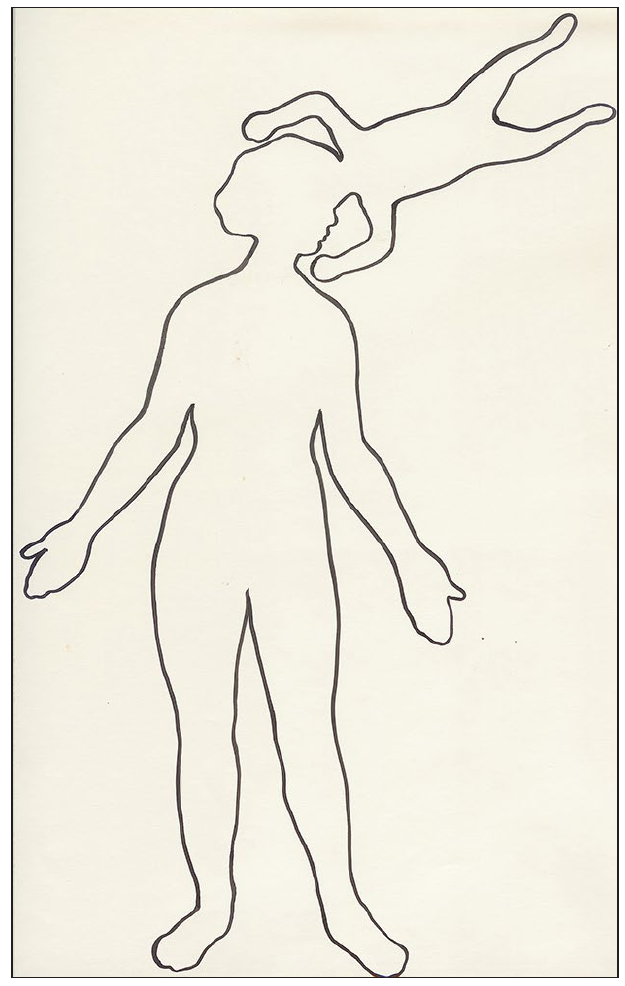
Figure 6: Untitled 1 , 2006, ink on paper, 296 × 199